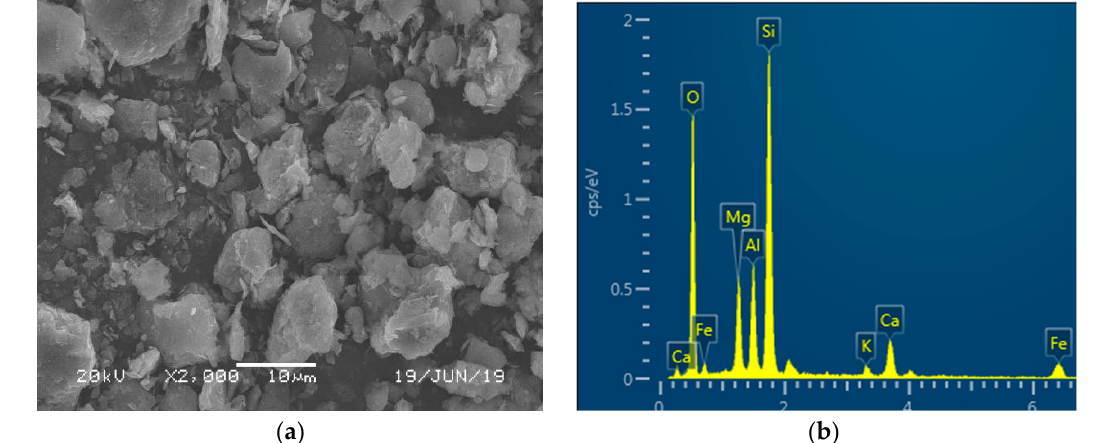
Table 4. Physical and mechanical indexes of nano silica.